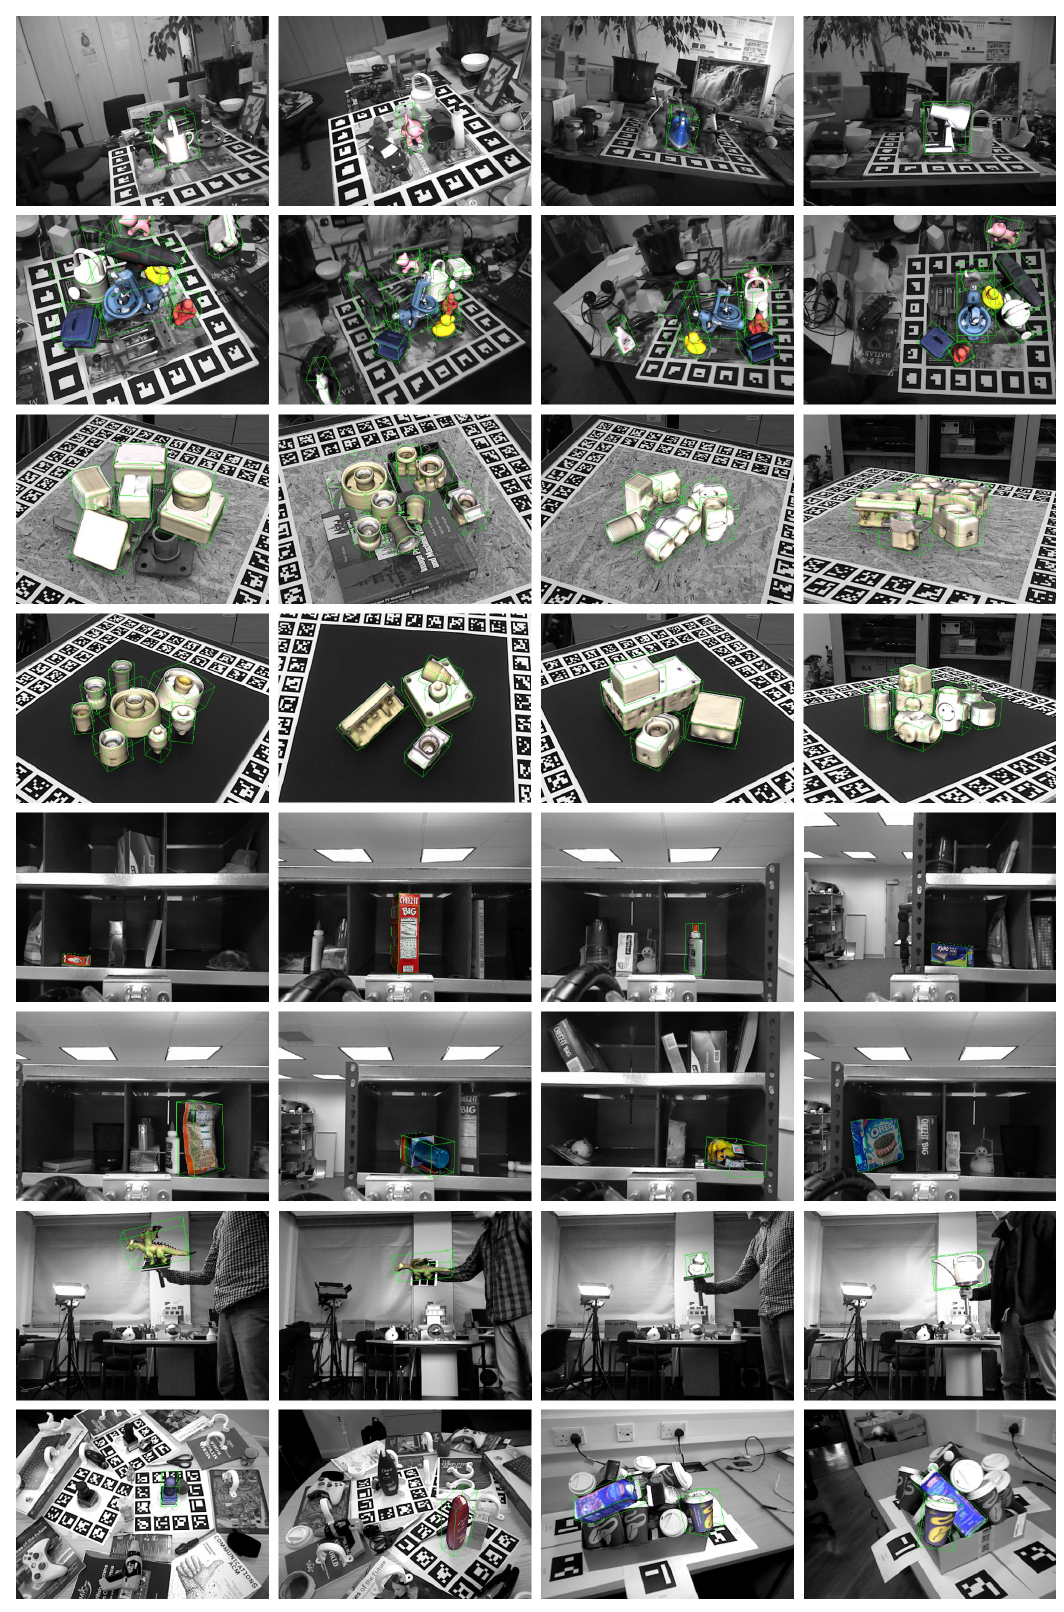
Figure 12. Proposed method results in scenes from the BOP benchmark datasets. Scene RGB data is shown in gray. Object models are shown in color and inside a green bounding box. Notice that, for scenes with multiple instances, only the most supported instance is